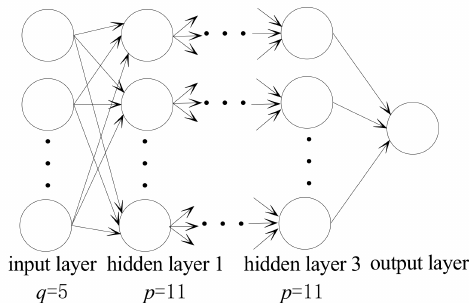
Figure 7. Model of the back propagation (BP) neural